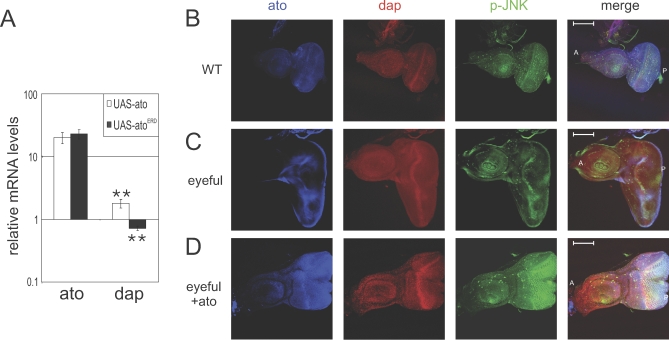
Ato Up-Regulates Dap and p-JNK(A) Quantitative RT-PCR for Ato (first two bars) and Dap (second two bars) upon Ato (white bars) and AtoERD (gray bars) expression, standardized to wild type and driver controls and to expression of three housekeeping genes. Error bars indicate the standard error of the mean. Double asterisks (**) indicate p < 0.01 (t-test).(B–D) Expression of ato in ey-GAL4, UAS-Dl, eyeful flies up-regulates Dap and phosphorylated JNK. (B) Third instar eye disc from wild type. (C) Third instar eye disc from ey-GAL4, UAS-Dl, eyeful/+. (D) Third instar eye discs from ey-GAL4, UAS-Dl, eyeful/UAS-ato. A indicates anterior; P indicates posterior.